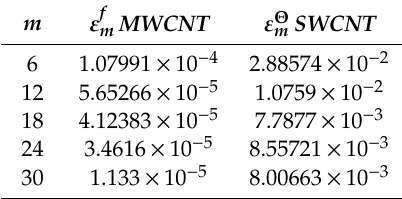
Table 3. The total sum of the averaged squared residual errors for the MWCNTs . When Pr = 6.7, M = Re = 0.1, φ =